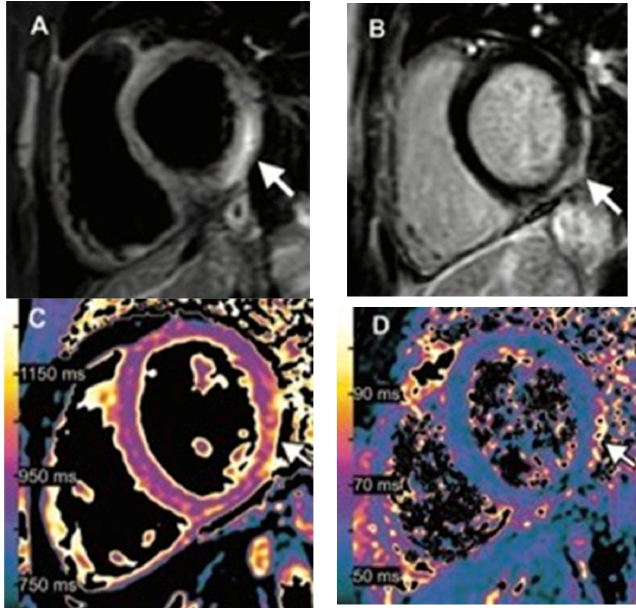
Figure 3. Images of a 15-year-old boy with myocarditis after COVID-19 vaccination. One day after receiving his second vaccination dose, he developed fever, myalgia, and intermittent tachycardia. ( A ) T2-weighted short inversion time inversion recovery MRI scans at 1.5 T in short-axis view show focal high-signal intensities (arrow) at the basal lateral and inferior wall, indicating myocardial edema. ( B ) Late gadolinium enhancement image in short-axis view shows corresponding linear subepicardial enhancement (arrow), indicating inflammatory myocardial necrosis. ( C ) T1 mapping and ( D ) T2 mapping in the short-axis view show elevated T1 and T2 at the mid-ventricular lateral and infero- lateral wall (arrow in ( C , D )), indicating acute myocardial injury (focal T1, 1165 ms; focal T2, 70 ms; institution-specific cut-off values for acute myocarditis: T1 global ≥ 1000 ms, T2 global ≥ 55.9 ms). Reprinted/adapted with permission from Ref. [8], 2021,